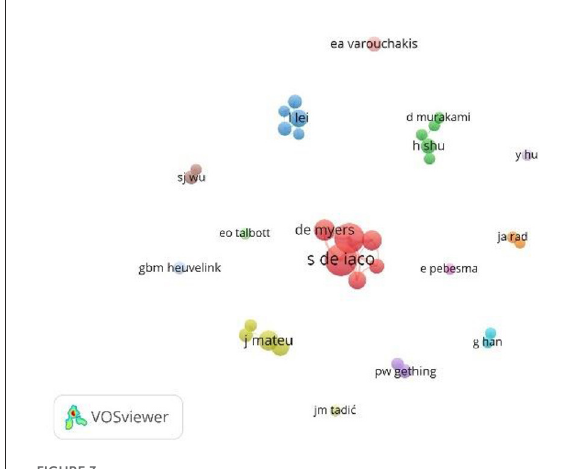
FIGURE3 Network visualization of co-citation